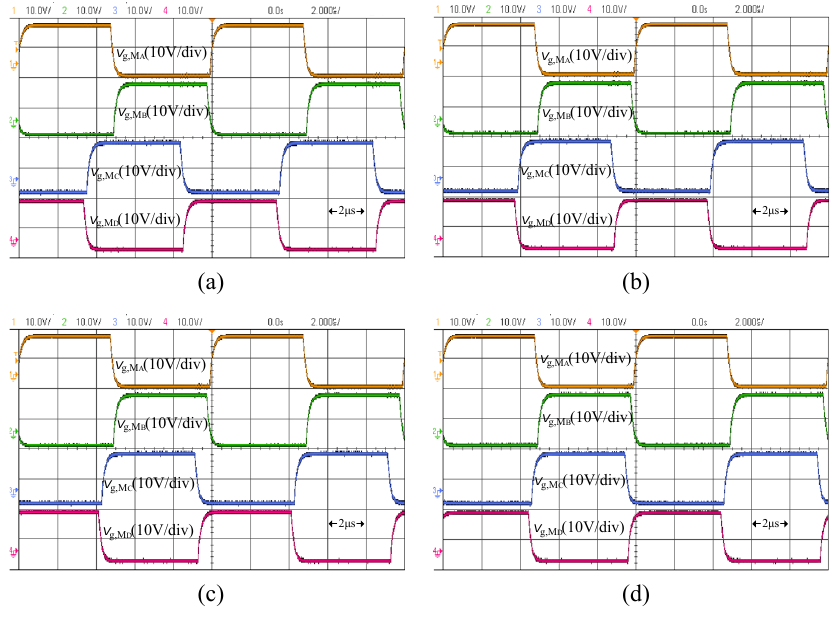
∼ v g , M D at different power levels: ( a ) 200 W, ( b ) 150 W, A